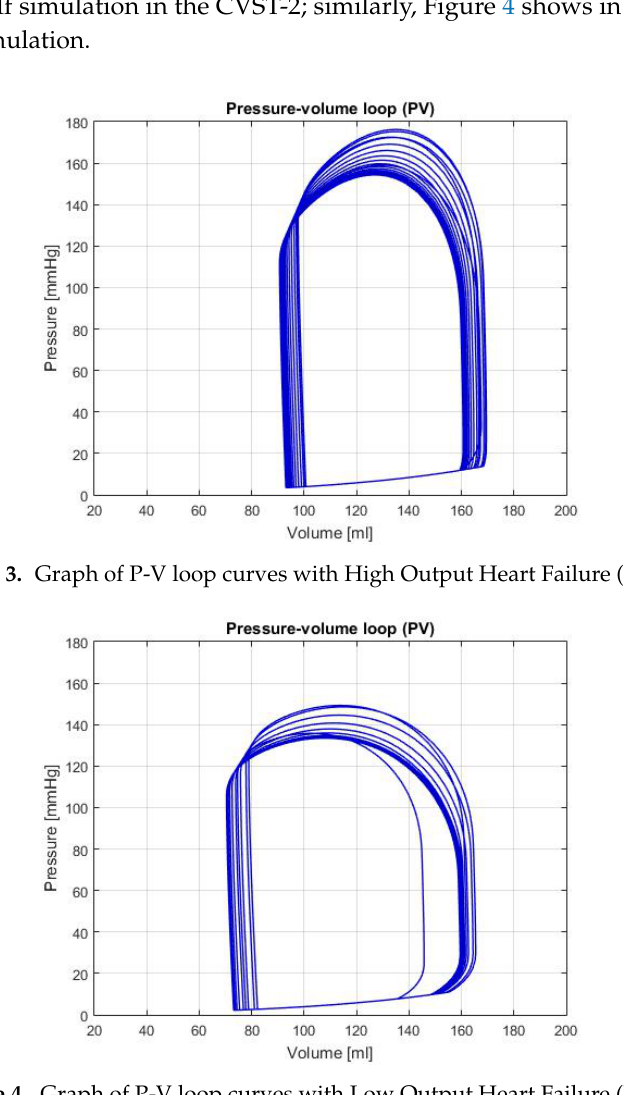
Figure 4. Graph of P-V loop curves with Low Output Heart Failure